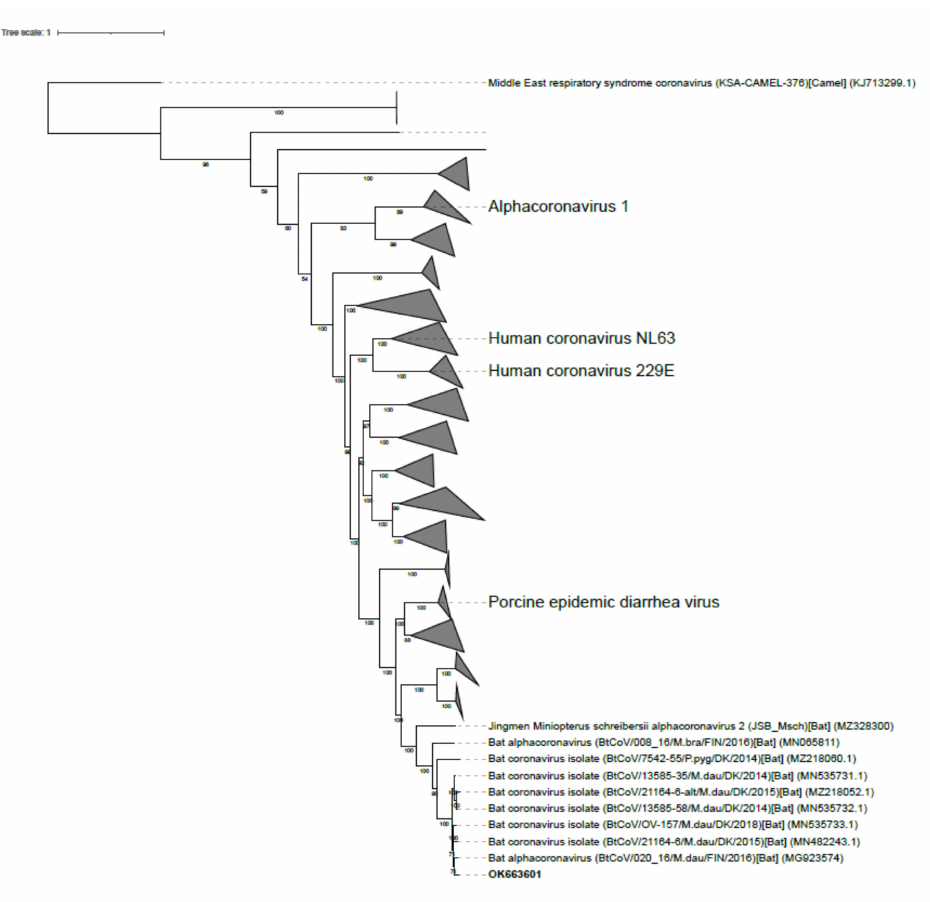
Figure 2. Phylogenetic relationships between the nucleotide sequence of the alpha-CoV detected in the study (OK663601 in bold) and 1328 other strains. The Middle East respiratory syndrome coronavirus (MERS-CoV) (KJ713299.1) was used as an outgroup. The differently shaped triangles symbolize clusters of related